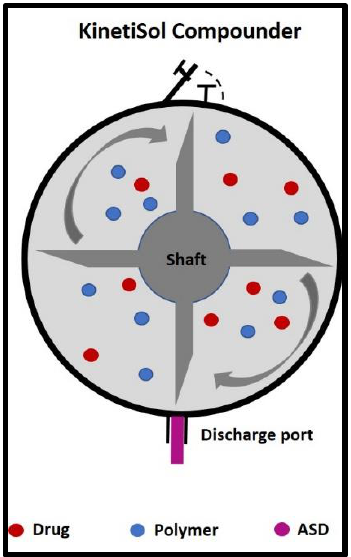
Figure 2. Preparation of ASD through KinetiSol ® technology.